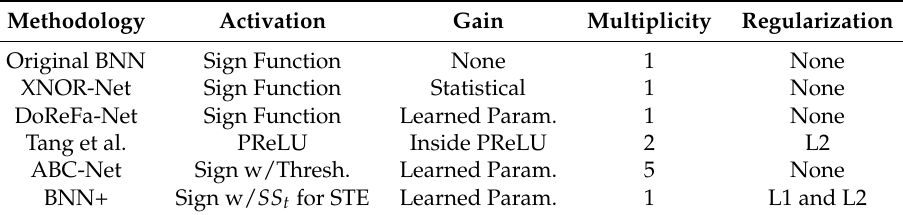
Table 4. A table of major details of the methods presented in this section. Activation refers to which kind of activation function is used. Gain describes how gain terms were added to the network. Multiplicity refers to how many binary convolutions were performed in parallel in place of full precision convolution layers. The regularization column indicates which kind of regularization was used, if